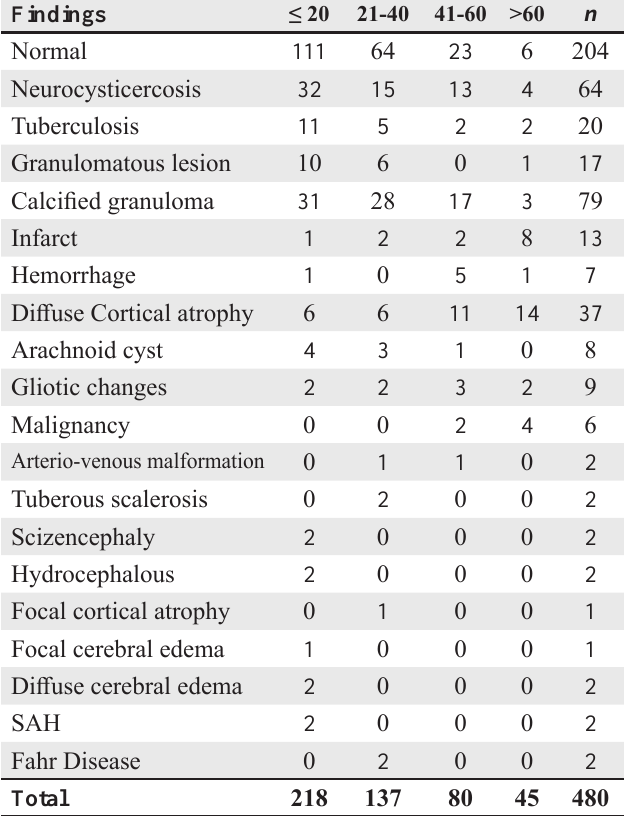
Table 2 : CT scan findings of patients with seizure according to age group (years).